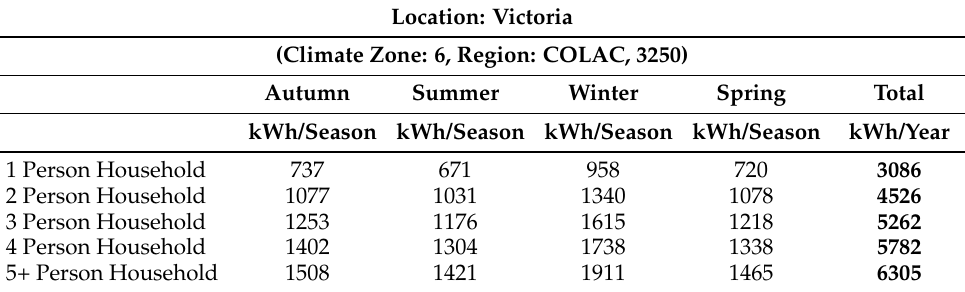
Table 5. Energy consumption benchmarks published by the Australian energy